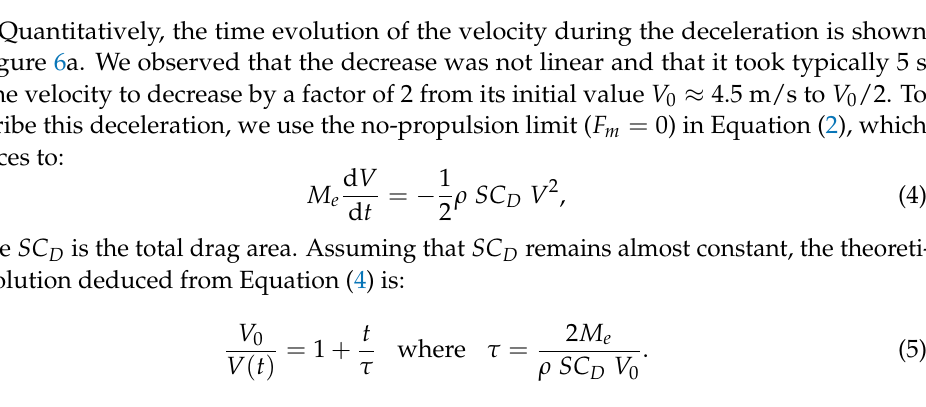
Figure 5. Chronophotography illustrating a deceleration test performed with L to measure the effective mass M e via the deceleration of the boat. The time between each frame was ∆ t = 0.167 s.